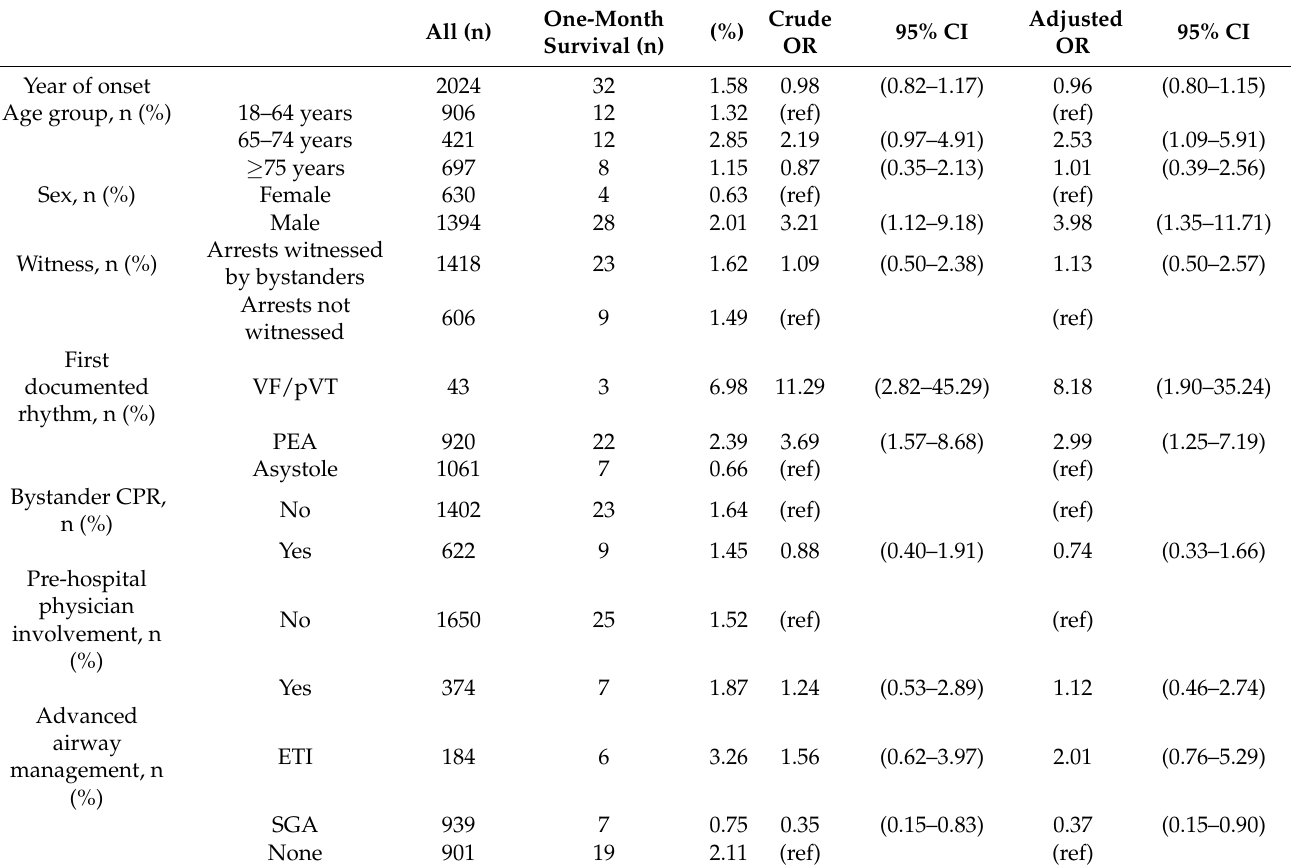
Table 3. The factors associated with one-month